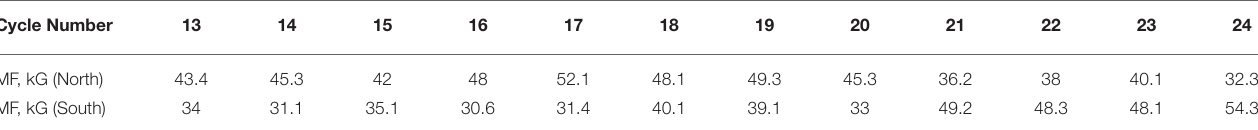
TABLE 2 | Estimated magnetic field strength (kG) using spherical Rossby waves for northern and southern hemispheres from GRO sunspot area data for solar cycles 13–24. Cycle Number MF, kG (North)